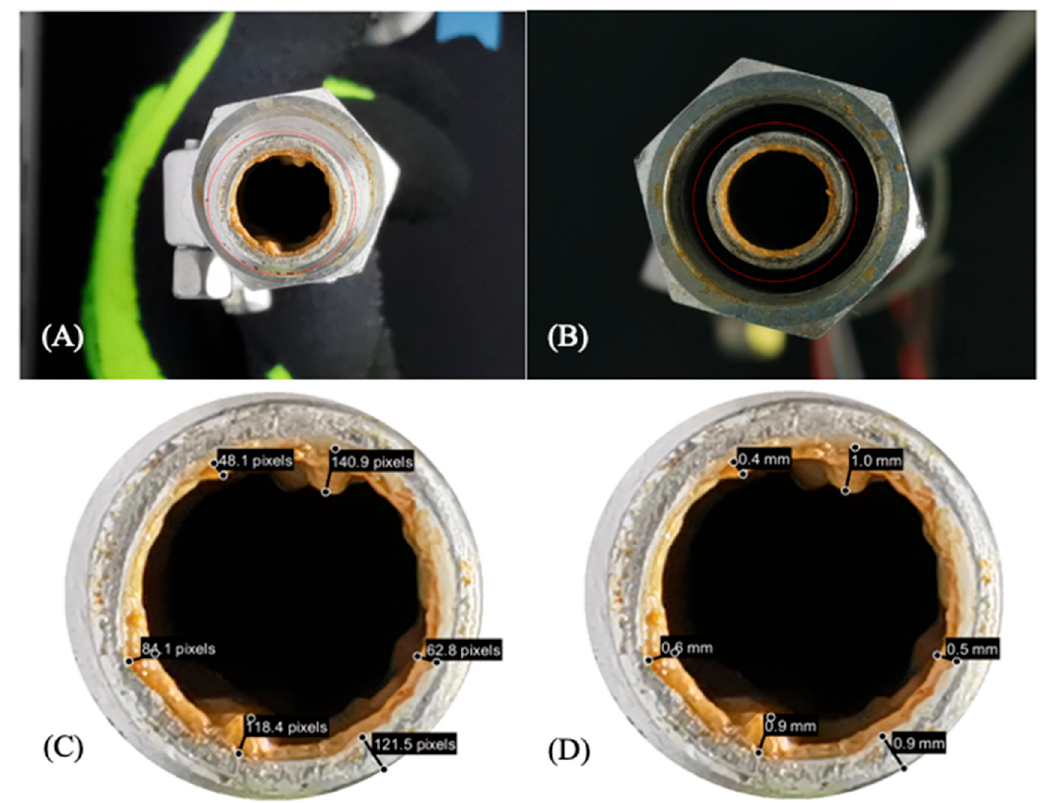
Figure 3. Photo of a fouled tube section mounted with Non-Intrusive Continuous Sensor (NICS) after ( A ) Heavy Whipping Cream (HWC) trial and ( B ) Non-Fat Dry Milk (NFDM) trial. ( C ) Regions of Interest (ROI) lines measuring pixels and scaling factor window, and ( D ) ROI lines measurements converted to corresponding units.